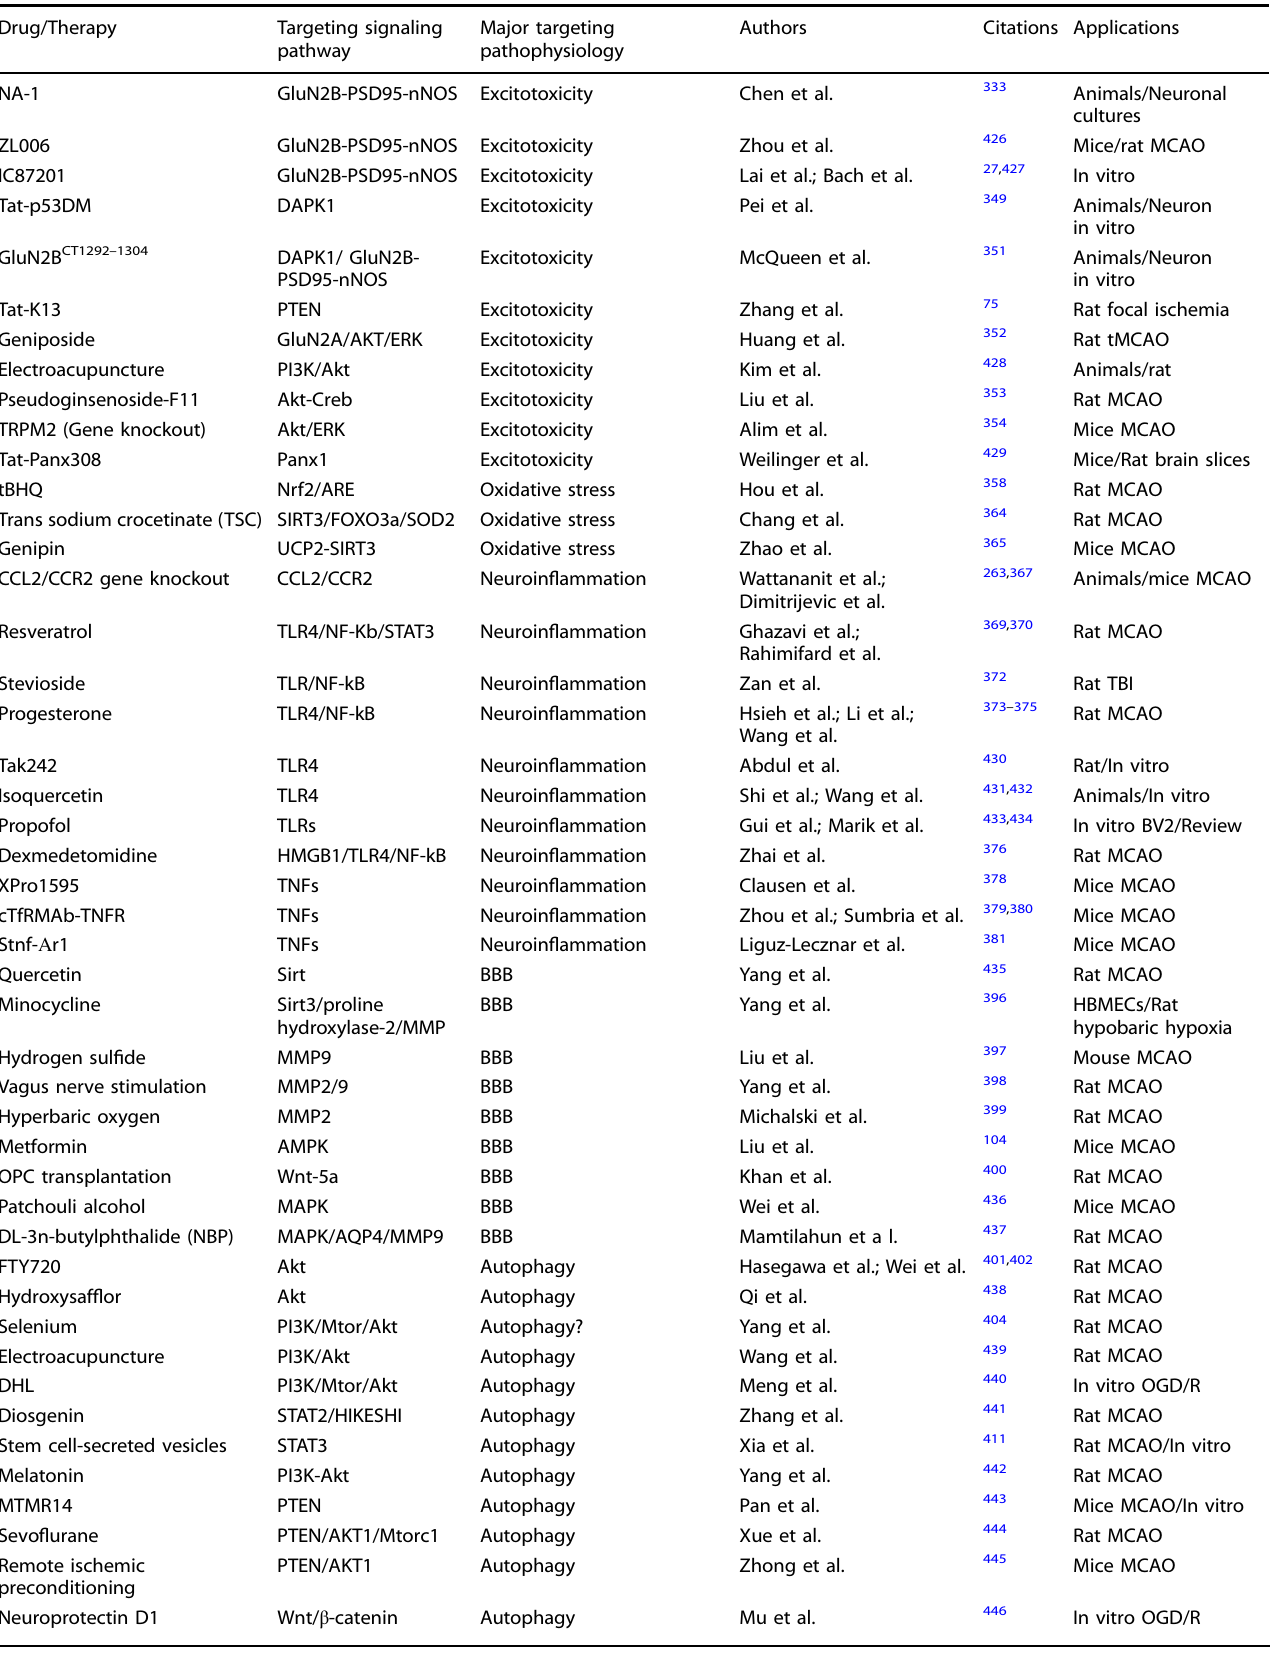
Table 1. Therapies targeting the related signaling pathways involved in the corresponding pathophysiology in ischemic stroke